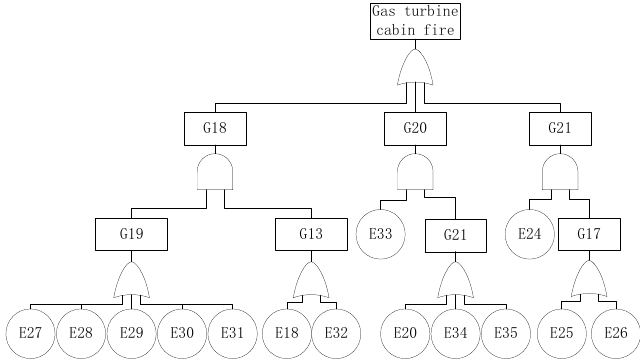
Figure 6. Fault tree of a gas turbine room fire. Table 9. Logic gates and principal events of a gas turbine room fire.